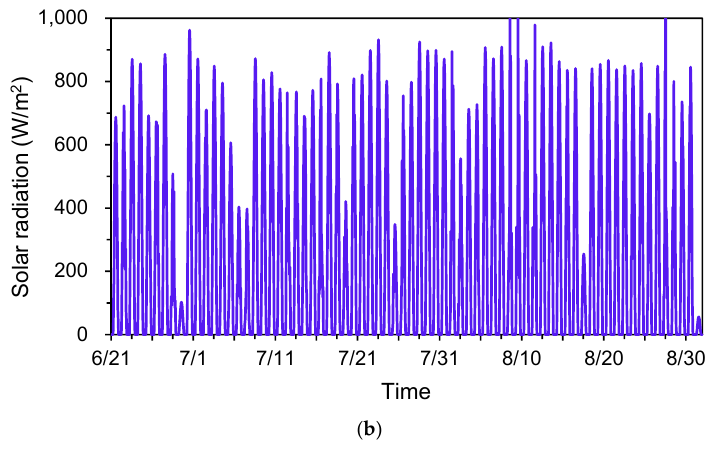
Figure 8. Climatic data of Urumqi: ( a ) Temperature of different sources; and ( b ) Horizontal solar radiation. The dynamic performance of the system applied to a west orientation is analyzed as an